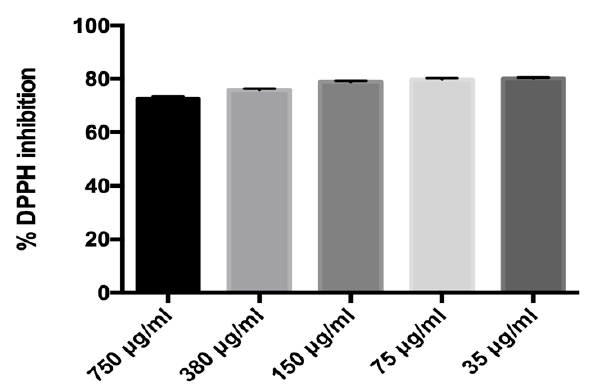
Figure 1. In vitro antioxidant activity measured through percentage of DPPH Inhibition.